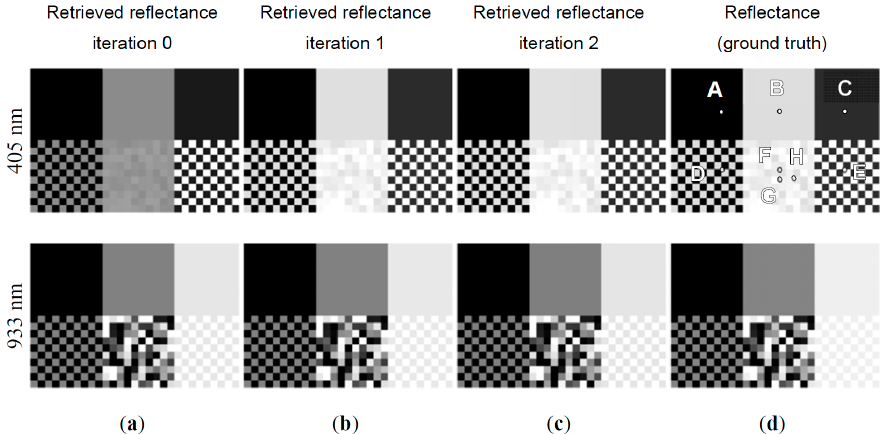
Figure 3. Retrieved reflectance after 0, 1 and 2 iterations (columns a to c ) compared with the corresponding ground truth ( d ). The images show the first (405 nm) and the last (993 nm) channel of the simulated sensor. The ground truth (column d) represents the ground image normalized for illumination effects and observed without the presence of the atmosphere. Such ground truth is obtained by the convolution of the high-spectral-resolution reflectance image (used as input for the at-sensor radiance simulation) with the sensor spectral response. Eight spectra have been selected in positions corresponding to the dots in the top-right image. The selected reflectance spectra (shown in Figures 4, 5 and 6) are representative of different ground conditions: pixels surrounded by spatially uniform reflectance (A, B, C); pixels surrounded by the chessboard spatial pattern, spectrally constant (D, E); pixel surrounded by chessboard spatial pattern, spectrally variable (F, G, H).